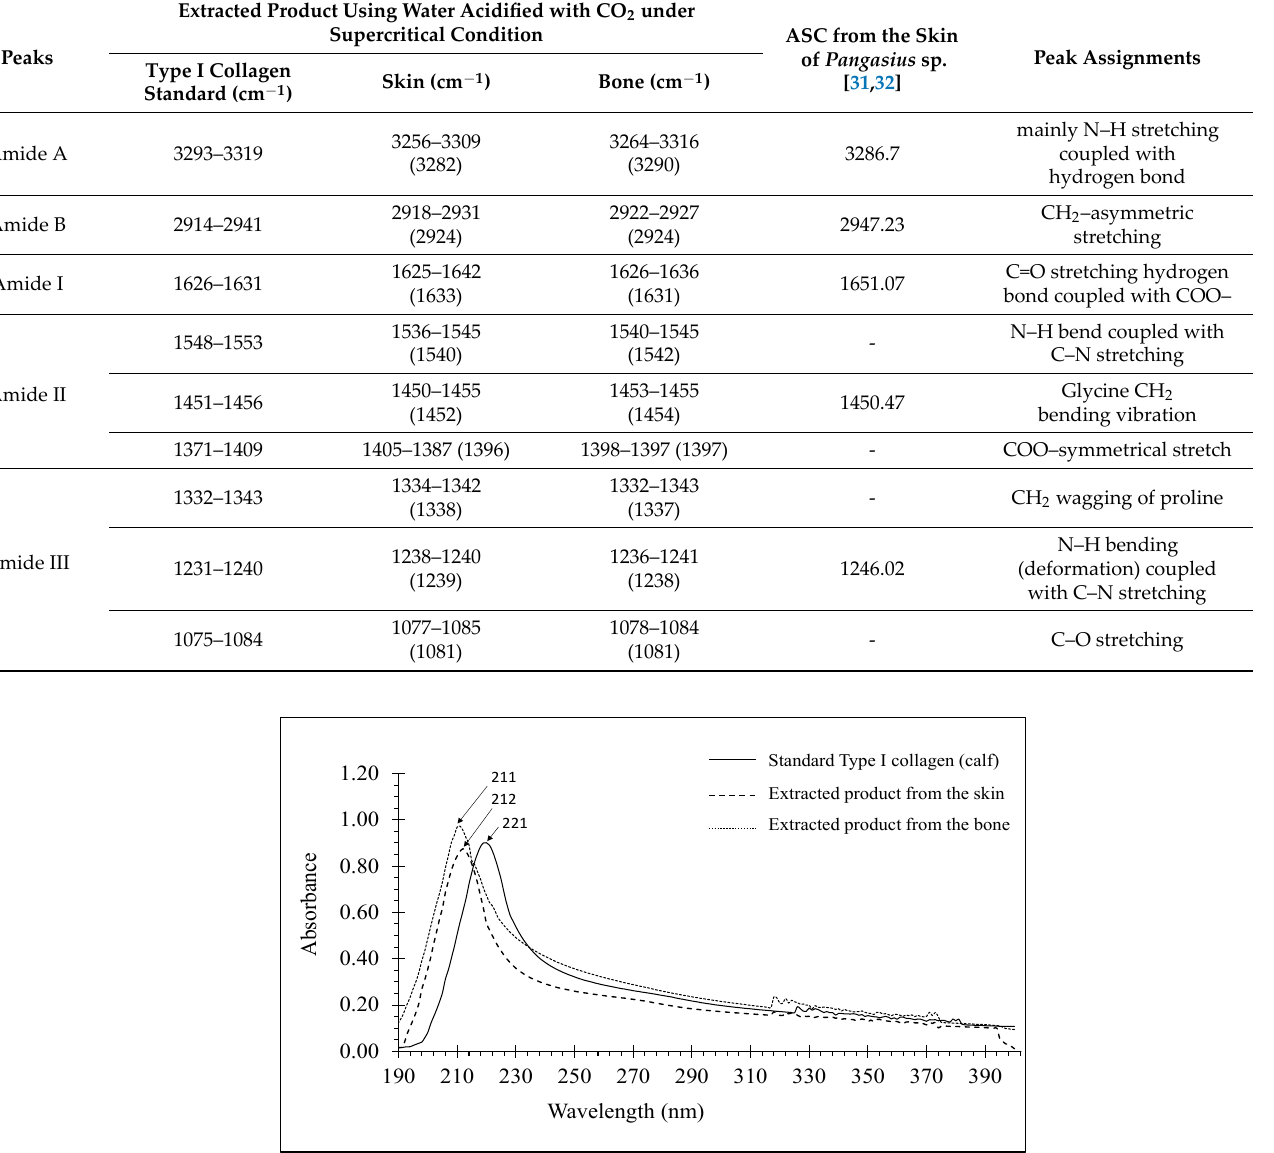
Figure 4. UV spectra of extracts from the skin and bone of striped catfish.